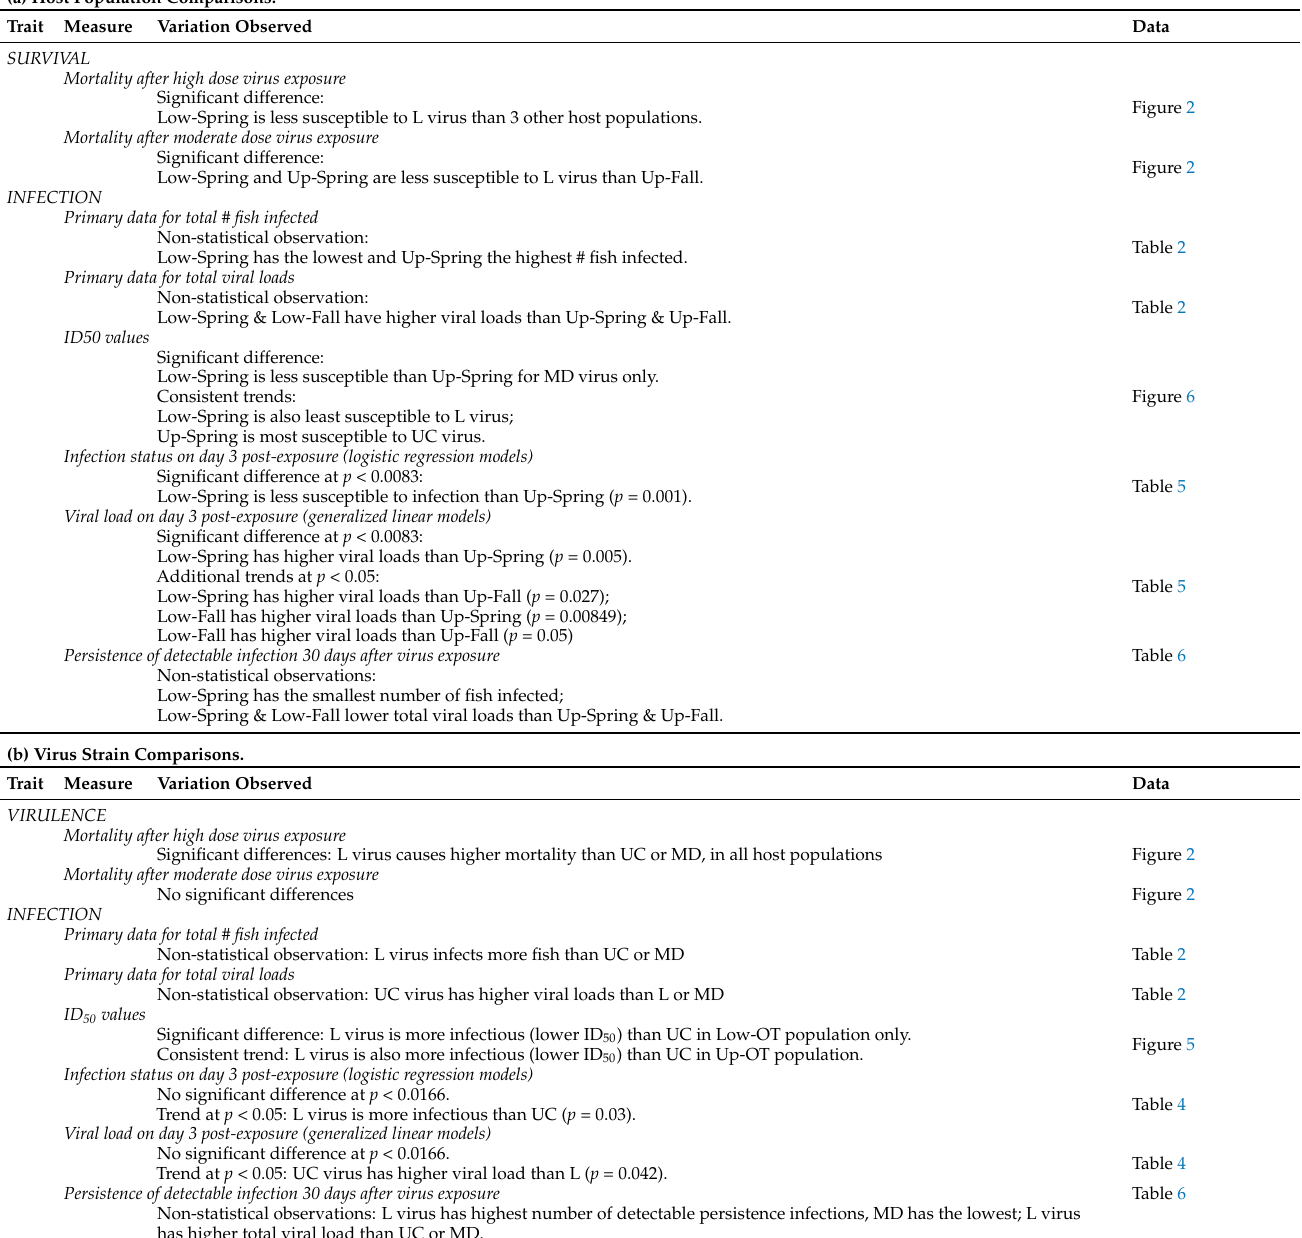
Trend at p < 0.05: L virus is more infectious than UC ( p = 0.03). Viral load on day 3 post-exposure (generalized linear models) No significant difference at p < 0.0166. Trend at p < 0.05: UC virus has higher viral load than L ( p = 0.042). Persistence of detectable infection 30 days after virus exposure Table 6 Non-statistical observations: L virus has highest number of detectable persistence infections, MD has the lowest; L virus has higher total viral load than UC or